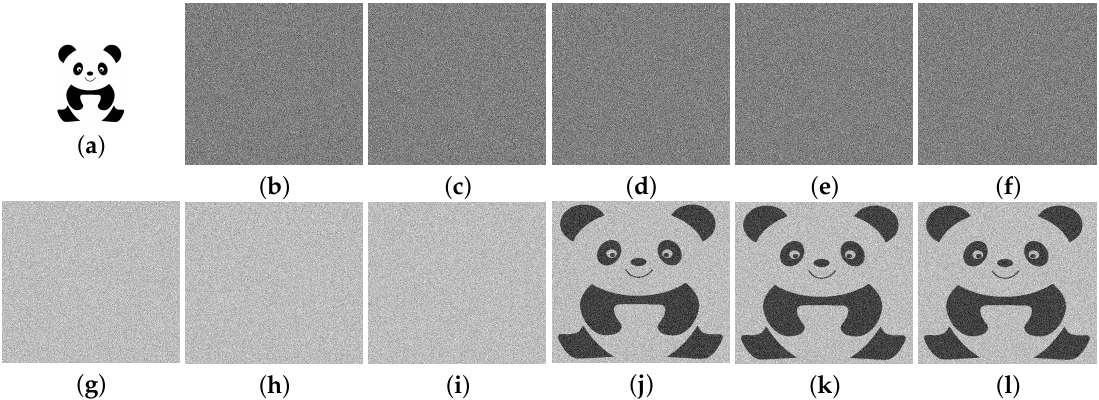
Figure 1. The shadow images and reconstructed images for a (3, 5)-XVC scheme: ( a ) secret image, ( b ) shadow S 1 , ( c ) shadow S 2 , ( d ) shadow S 3 , ( e ) shadow S 4 , ( f ) shadow S 5 , ( g ) S 1 ⊗ S 2 , ( h ) S 3 ⊗ S 4 , ( i ) S 2 ⊗ S 5 , ( j ) S 1 ⊗ S 2 ⊗ S 3 , ( k ) S 2 ⊗ S 3 ⊗ S 4 , ( l ) S 3 ⊗ S 4 ⊗ S 5